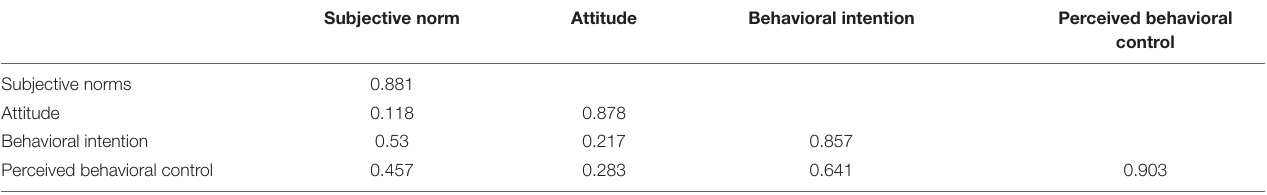
TABLE 2 | Analysis of discriminant validity (Fornell–Larcker criterion).